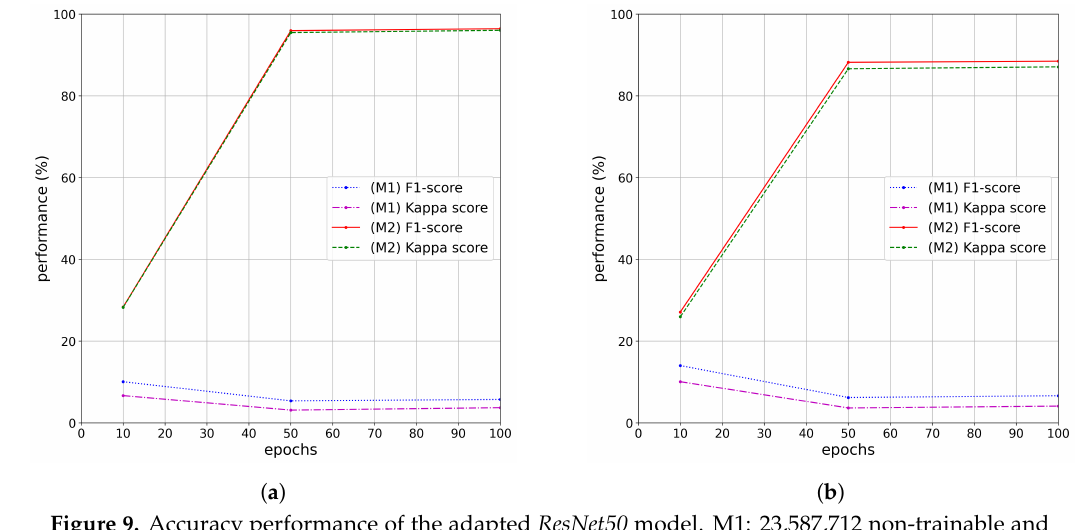
Figure 9. Accuracy performance of the adapted ResNet50 model. M1: 23,587,712 non-trainable and 1,054,233 trainable parameters, and M2: 53,120 non-trainable and 24,591,946 trainable parameters. ( a ) Both training and testing is based on the EuroSAT set; ( b ) training with the EuroSAT set and testing on the BigEarthNet-v1.0.